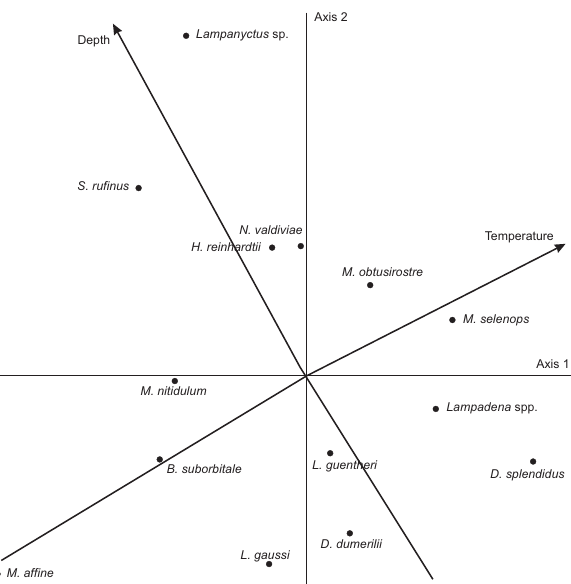
Figure 13. Canonical Correspondence Analysis between the most frequently collected myctophid taxa and environmental param- eters (temperature at 20 m depth and local